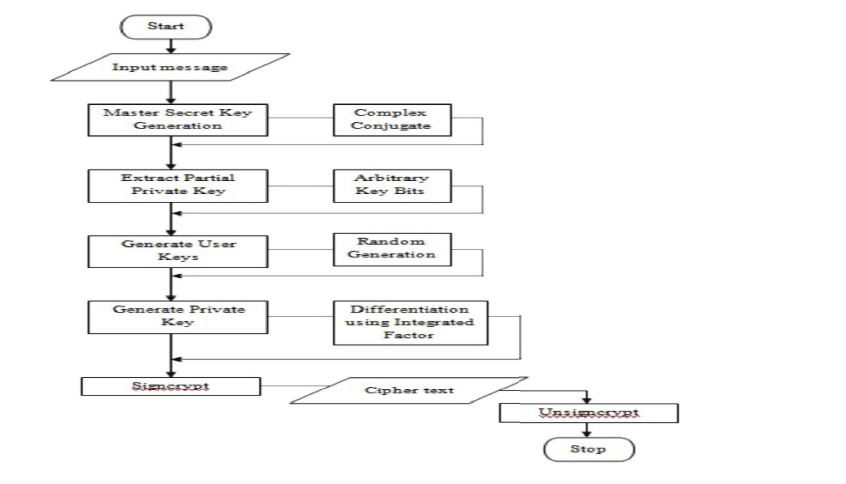
Fig 2. Flow diagram of CC-DIF.